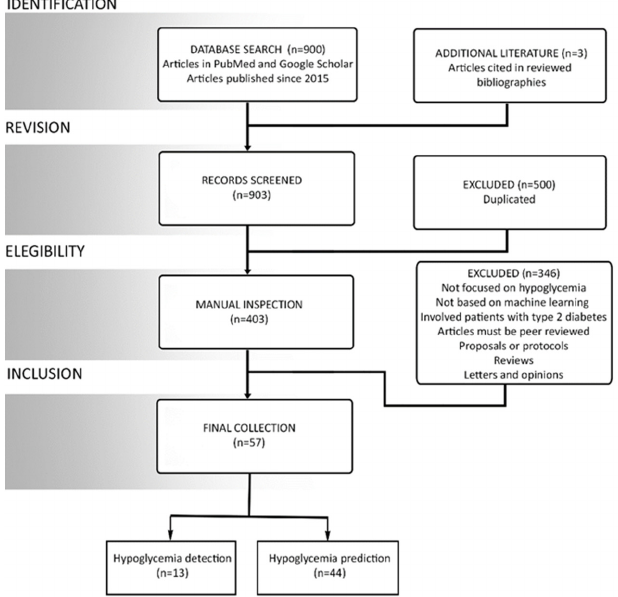
Figure 1. Overview of the review process and classification of literature.